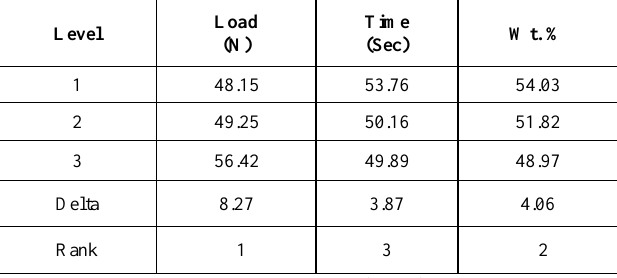
Table 6: Response Table for Signal to Noise Ratios at speed of